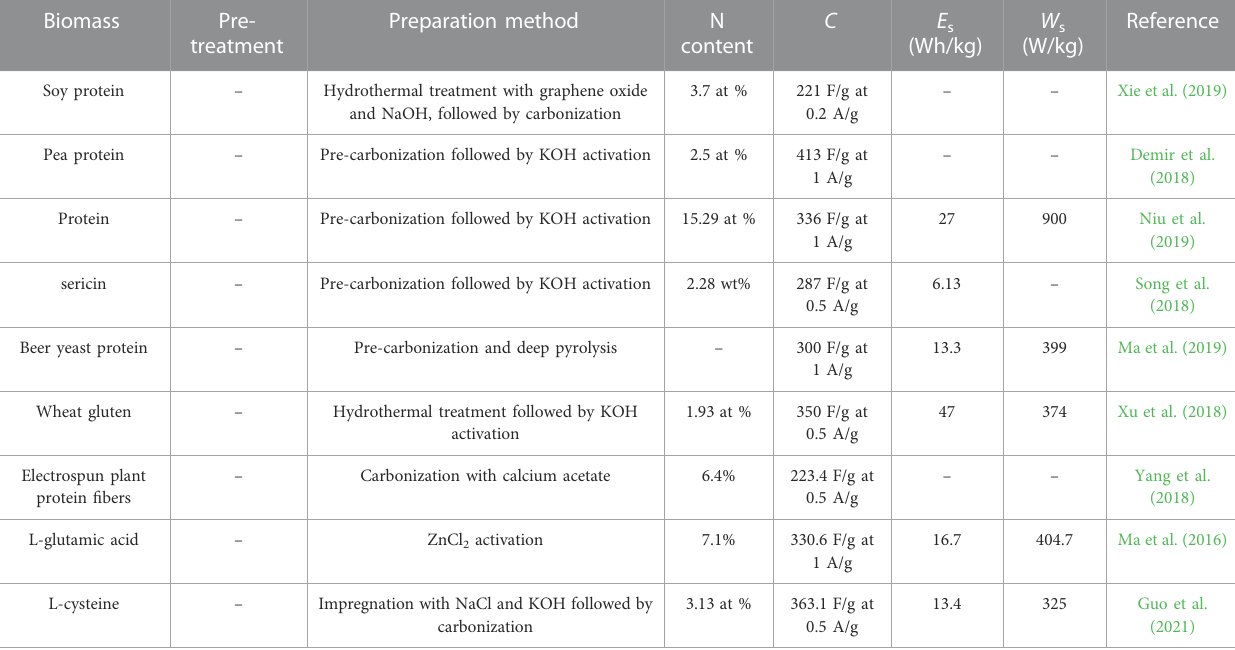
TABLE 6 Protein/amino acid-based N self-doped biochar applications in supercapacitors.